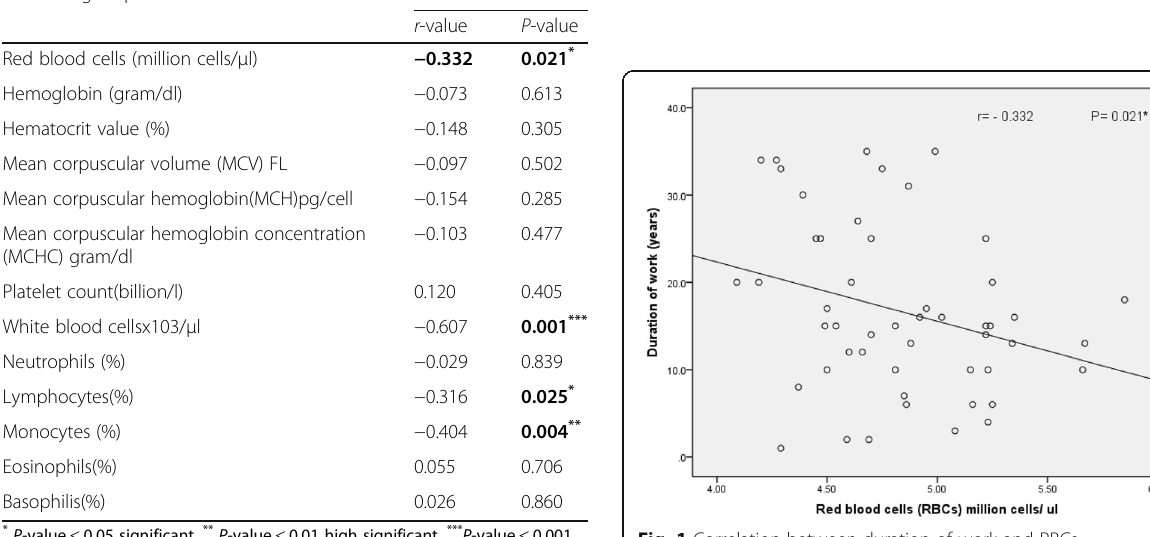
Table 8 Correlation between duration of exposure of workers (years) to paint hazards and hematological parameters Hematological parameters